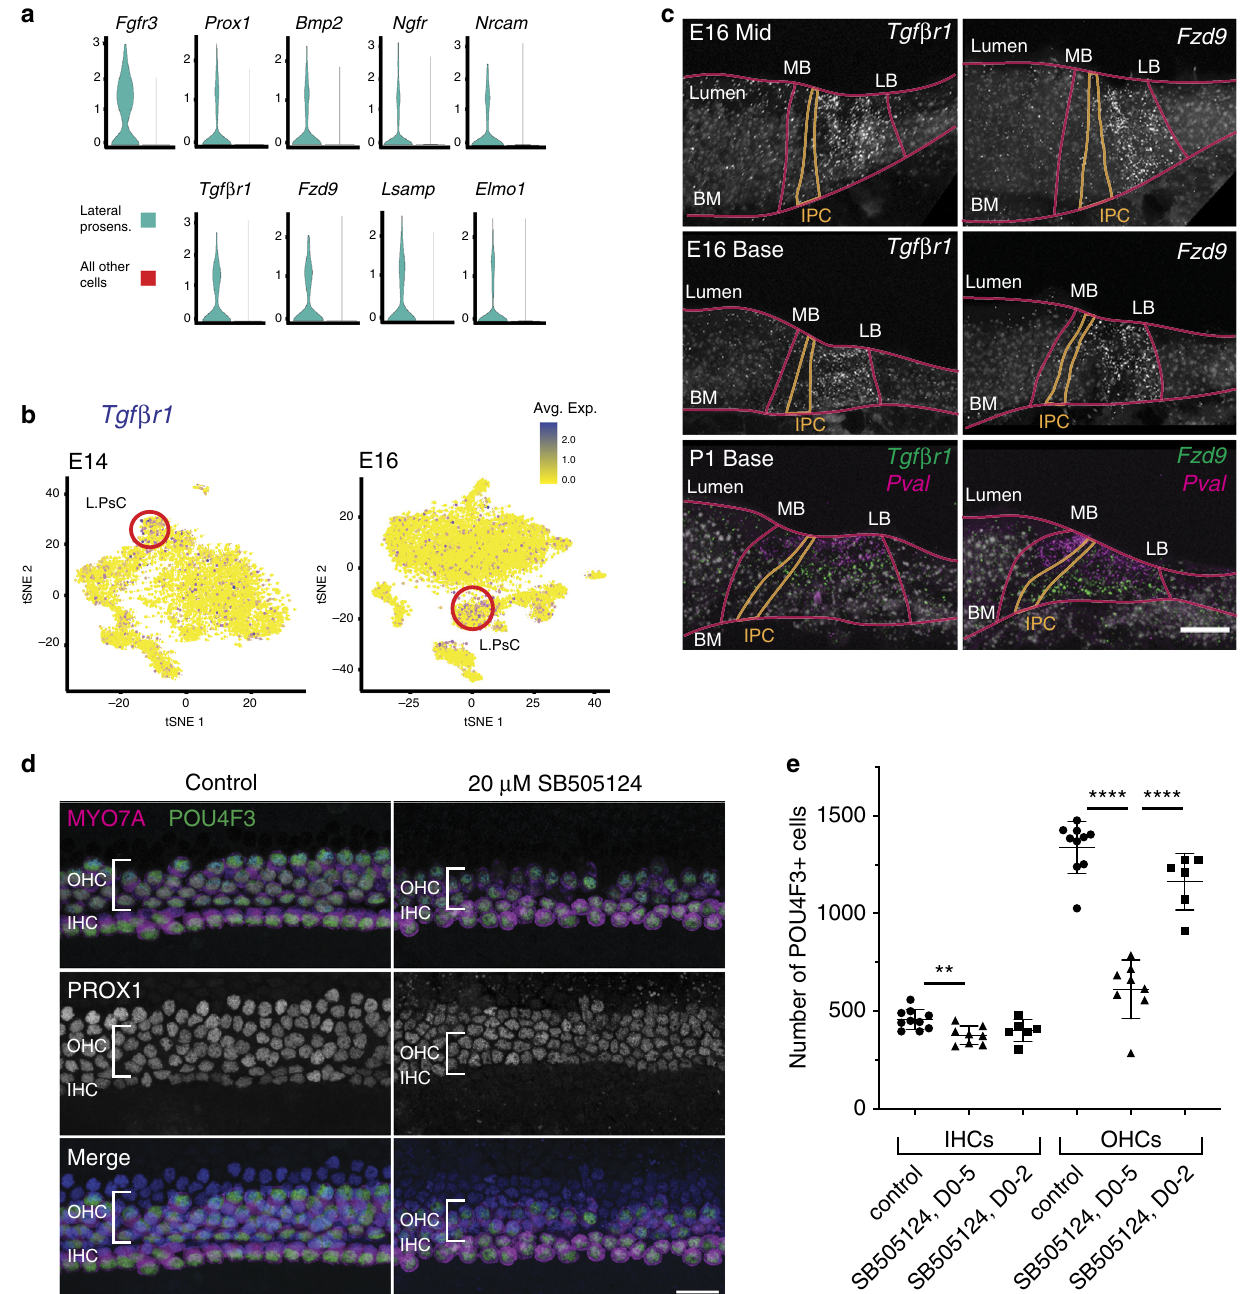
Fig. 5 Tgf β r1 activity is required for formation of the lateral prosensory domain. a Violin plots for fi ve genes, Fgfr3 , Prox1 , Bmp2 , Ngf , and Nrcam , that had previously been reported to be expressed in the lateral prosensory domain. Bottom row illustrates examples with similar patterns of expression that have not been previously reported in prosensory cells. b Feature plots for Tgf β r1 at E14 and E16. Expression is concentrated in the LPsCs (red circles). See Fig. 4a, b for cluster identities. c smFISH con fi rms expression of Tgf β r1 and Fzd9 only in the lateral prosensory domain. Red lines indicate lumenal surface (lumen), basement membrane (BM), and approximate locations for medial (MB) and lateral (LB) boundaries of the OC. Approximate positions of IPCs (gold). At P1, expression of both Tgf β r1 and Fzd9 (green) is restricted to lateral SCs. HCs are marked with Pvalb (magenta). Minimum of two samples per probe with similar results. d Cochlear explants established on E14 and treated with either DMSO (control) or the Tgf β r1 antagonist SB505124 at 20 μ M for 5 DIV. HC cytoplasm (anti-MYO7A, magenta) and nuclei (anti-POU4F3, green) and supporting cell nuclei (anti-PROX1, white or blue in merged image in bottom row) are labeled. Development of the lateral region of the OC is clearly disrupted (bracket), while the medial (IHC) region appears relatively unaffected. e Quanti fi cation of HC numbers per explant indicates a signi fi cant decrease in OHCs following 20 μ M SB505124 treatment for 5 DIV (DO-5). A slight, but signi fi cant decrease in IHCs was also observed. Explants treated with 20 µ M SB505124 for only 2 DIV (DO-2) followed by three additional days in control media did not show signi fi cant decreases in IHCs or OHCs. Data are presented as mean values ± SD, ** p = 0.0093, **** p < 0.0001. n = 24 biologically independent explants (ten control, eight SB505124, DO-5, six SB505124, DO-2) with a total of n = 35,217 HCs counted over three separate experiments. Statistical test is one-way ANOVA followed by Tukey ’ s multiple comparison ’ s test. Source data are supplied as a Source data fi le. Scale bars in c and d , 20 μ